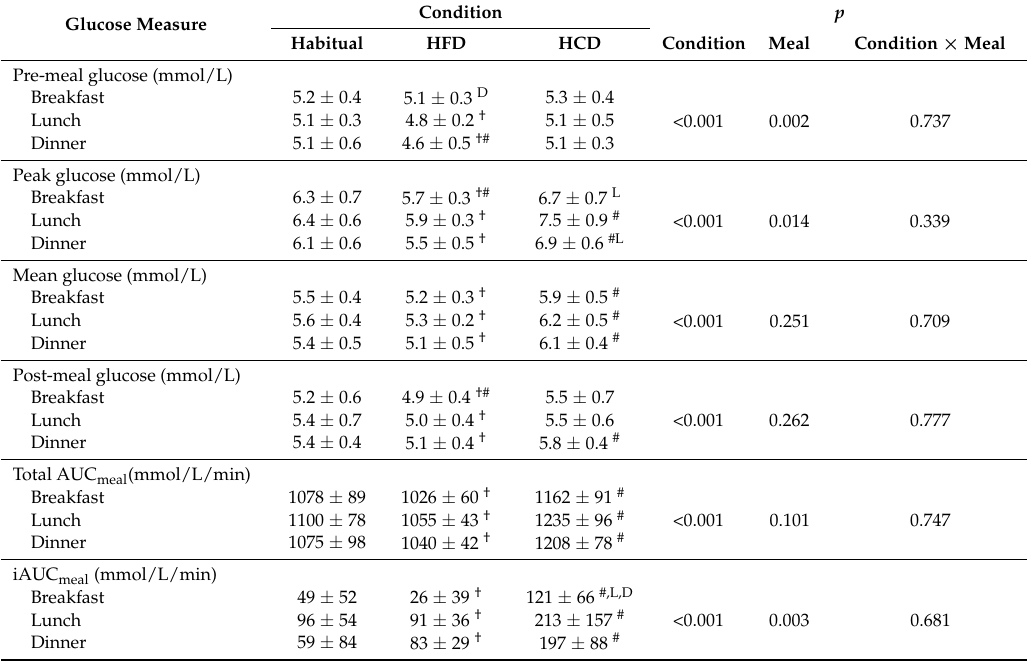
Table 4. Continuous glucose monitor analysis from 3-h postprandial periods across the average of the habitual periods ( Day − 6 to Day − 1 ) and the two experimental diet ( Days 1–5 ) periods from overweight, sedentary males ( n =